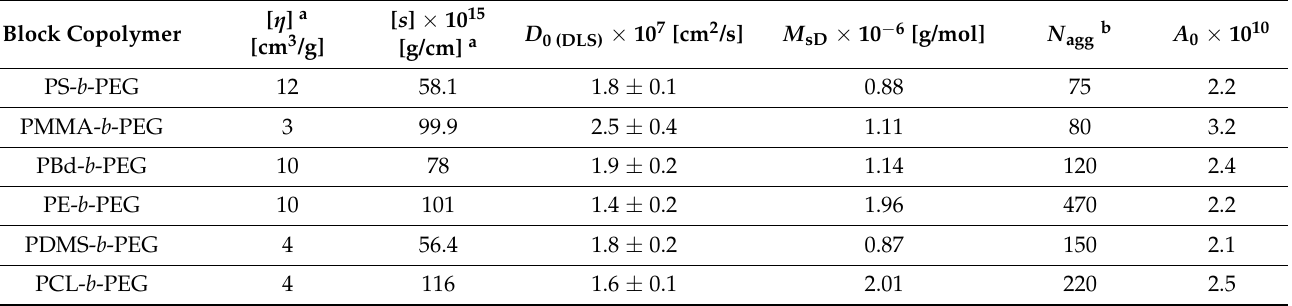
Table 5. Hydrodynamic parameters, hydrodynamic invariants, and molar masses of block copolymers micelles in H 2 O at 25 ◦ C obtained by viscometry, DLS, and AUC.